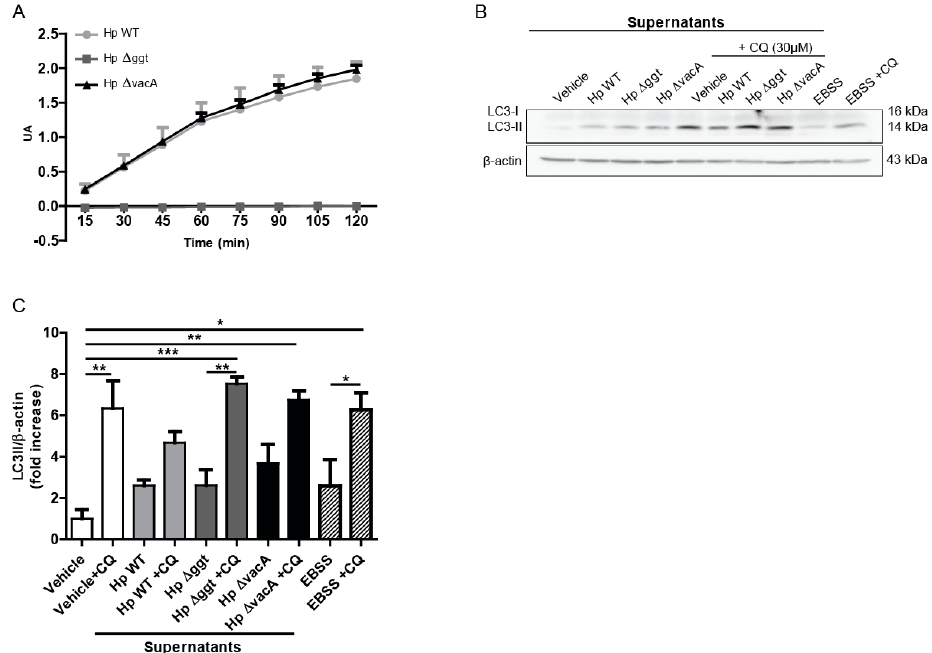
Figure 2. Hp ∆ ggt culture supernatant increases autophagic flux of AGS cells in comparison with the parental strain. ( A ) Activity of gamma-glutamyltranspeptidase in cell lysates of wild type (HpWT) and the isogenic Hp ∆ ggt and Hp ∆ vacA mutants (lacking gamma-glutamyltranspeptidase and vacuolating toxin, respectively). ( B ) AGS cells were incubated for 6 h with the concentrated supernatants from wild type, Hp ∆ ggt and Hp ∆ vacA H. pylori strains (1:25) in the presence or absence of chloroquine (30 µ M). As a control, concentrated non-conditioned medium (vehicle) was added at a similar dilution. In addition, Earle’s Balanced Salt Solution medium (amino acid and serum free medium) was used as a positive control to induce autophagy (4 h). Protein levels of the microtubule-associated protein 1A / 1B light chain 3 (LC3) conjugated to phosphatidylethanolamine (LC3-II) and β -actin were evaluated by Western blotting. In panel C ) the quantification of relative levels of LC3-II for AGS cells is shown. These data represent the mean ± the standard error of the mean (SEM) of three independent experiments. * p < 0.05, ** p < 0.01, *** p <